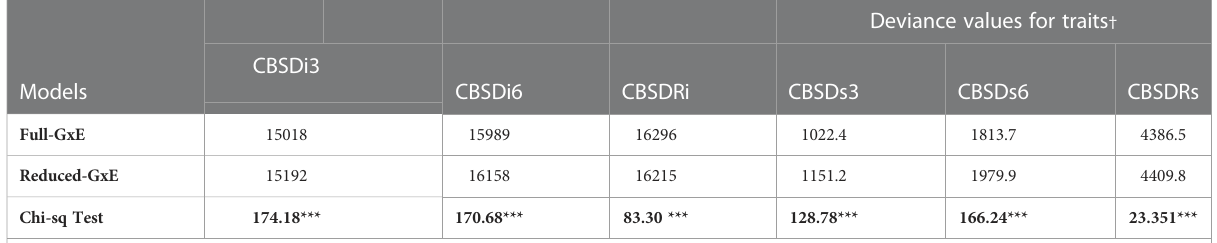
TABLE 2 A chi-square test comparing the deviance values for G x E model (Full Model) with a model fi tted without G x E term (Reduced model).